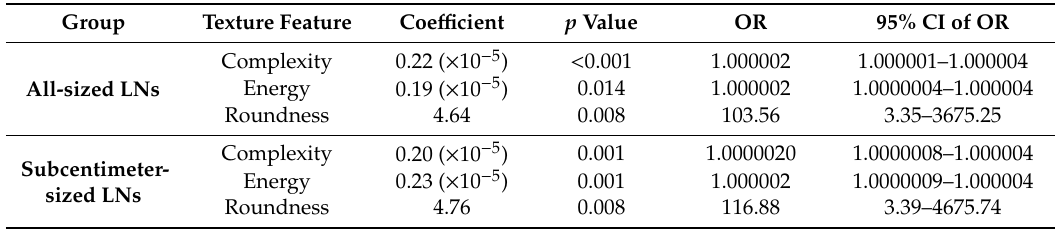
Table 1. Results of multivariate logistic regression analysis with Cox proportional hazards model using independent texture